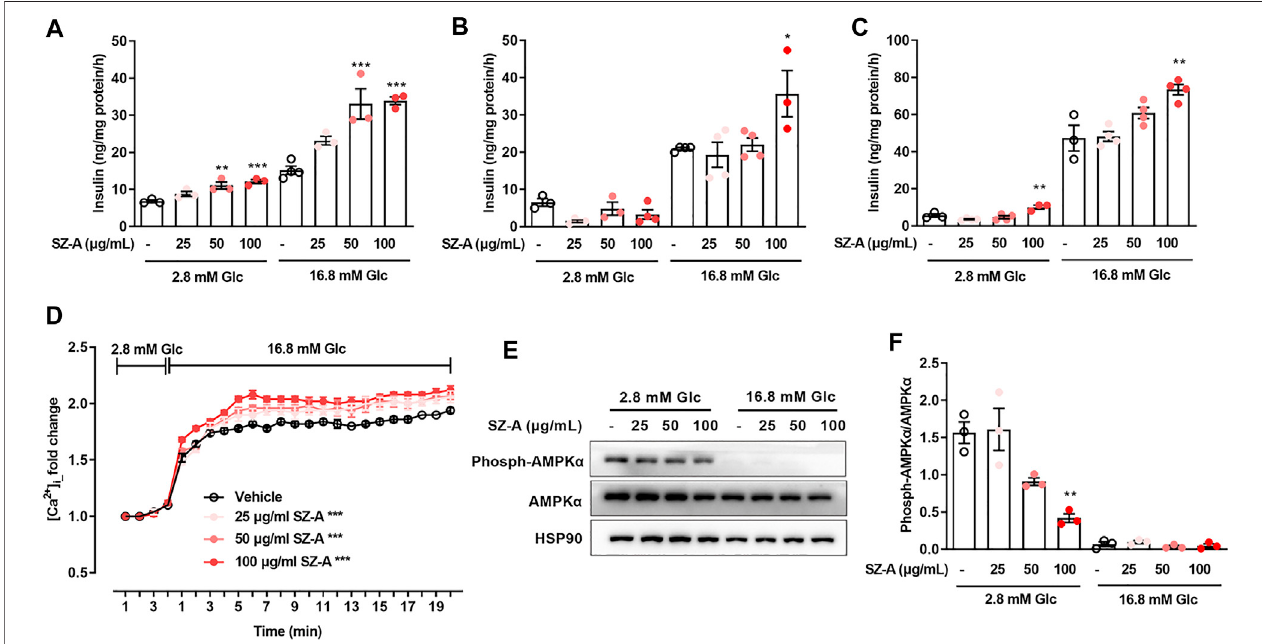
FIGURE 3 | SZ-A promoted insulin secretion in MIN6 cells and mouse primary islets, and advanced glucose-dependent [Ca 2+ ] i changes and inhibited AMPK α phosphorylationinMIN6cells. (A – C) MIN6cellsorisletswerepreincubatedwith25,50,or100 μ g/mlSZ-Aorvehiclefor1 h.Glucose-stimulatedinsulinsecretionassay in MIN6 cells (A) , islets of normal C57BL/6J mice (B) and islets of type 2 diabetic KKA y mice (C) at glucose concentrations of 2.8 and 16.8 mM ( n = 3 or 4 replicates per group). (D) The changes in [Ca 2+ ] i of MIN6 cells were labeled by Fluo4-AM when MIN6 cells were treated with 25, 50, or 100 μ g/ml SZ-A or vehicle while elevating the glucose concentration from 2.8 to 16.8 mM ( n = 5 replicates in each condition). (E,F) AMPK α expression level and AMPK α phosphorylation level in MIN6 cells incubated with 25, 50, or 100 μ g/ml SZ-A or vehicle at glucoseconcentrations of2.8 and 16.8 mM for 1 h ( n = 3 replicates in each group). All data are expressed as